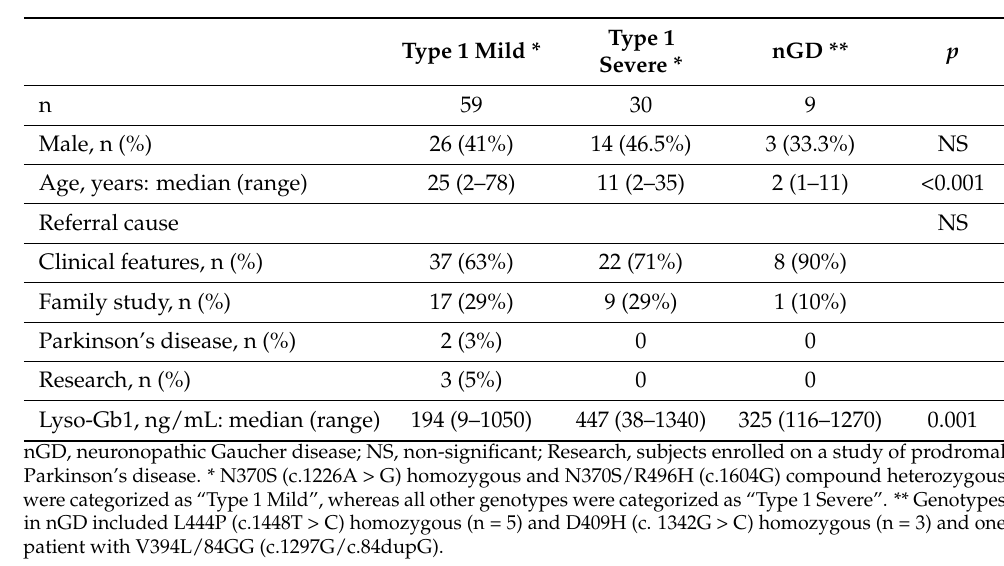
Table 3. Genetic variants in patients with Gaucher disease.